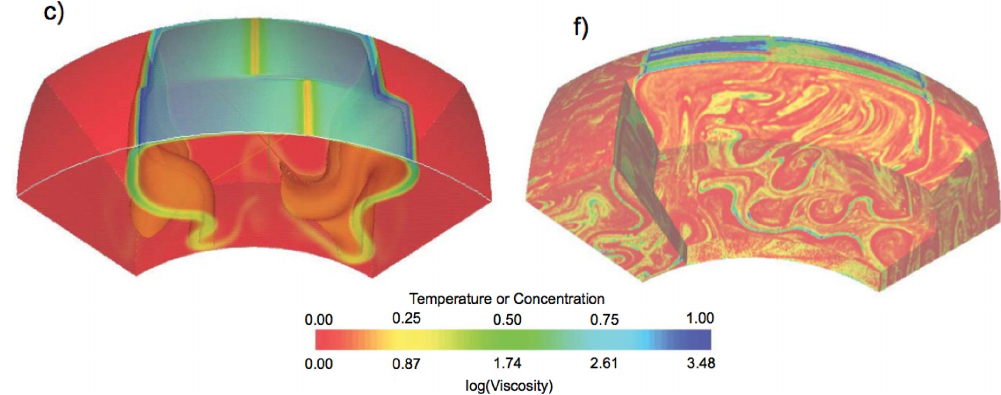
Fig. 11. Images from the three-dimensional regional model of Huang and Davies (2007c). (c) Temperature after 200Myr of model time, (f) tracer concentration after 18Gyr of model time. Copyright American Geophysical